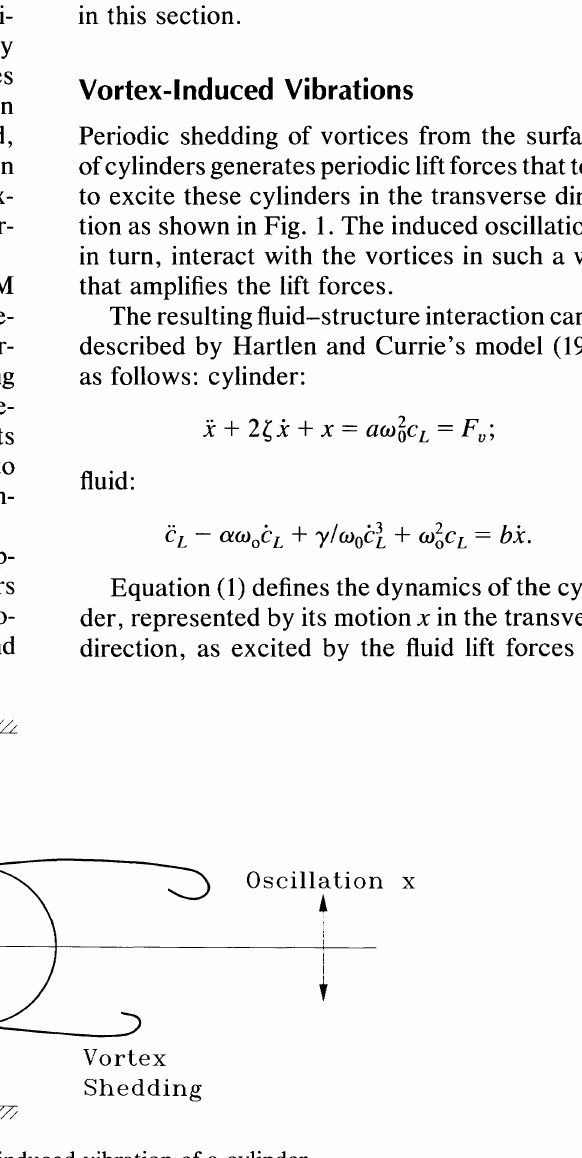
FIGURE 1 Vortex-induced vibration of a